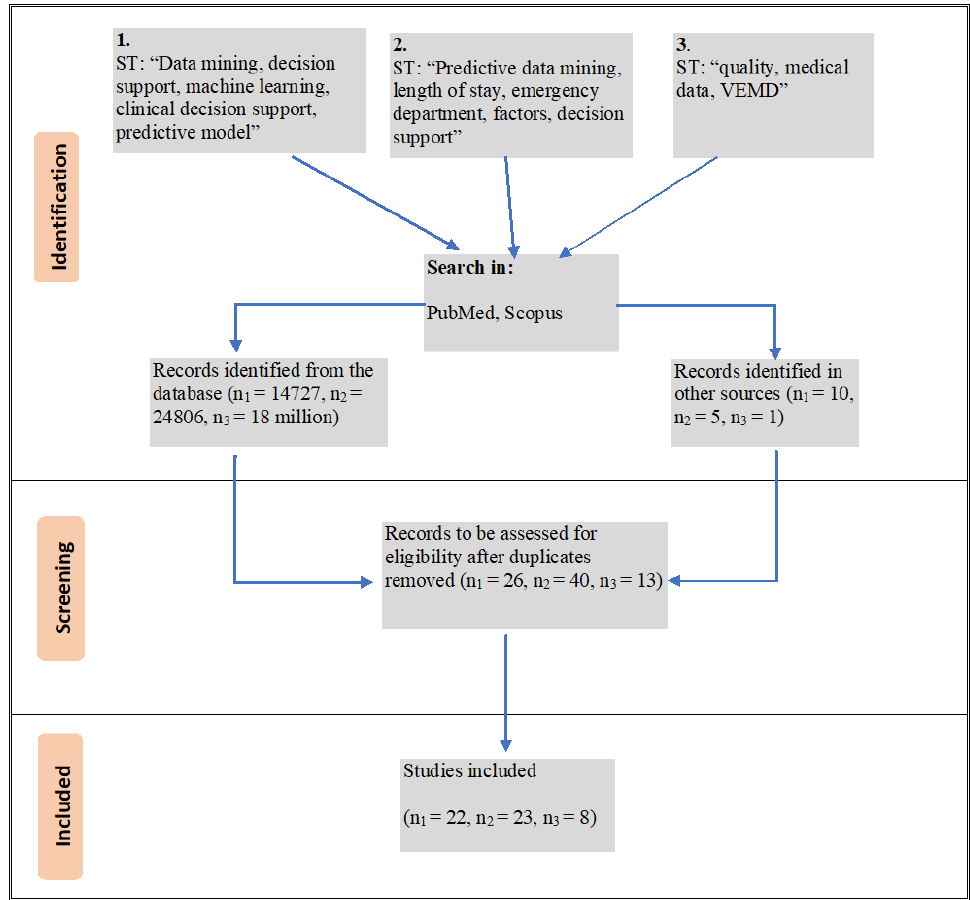
Figure 1. Systematic literature survey to identify suitable